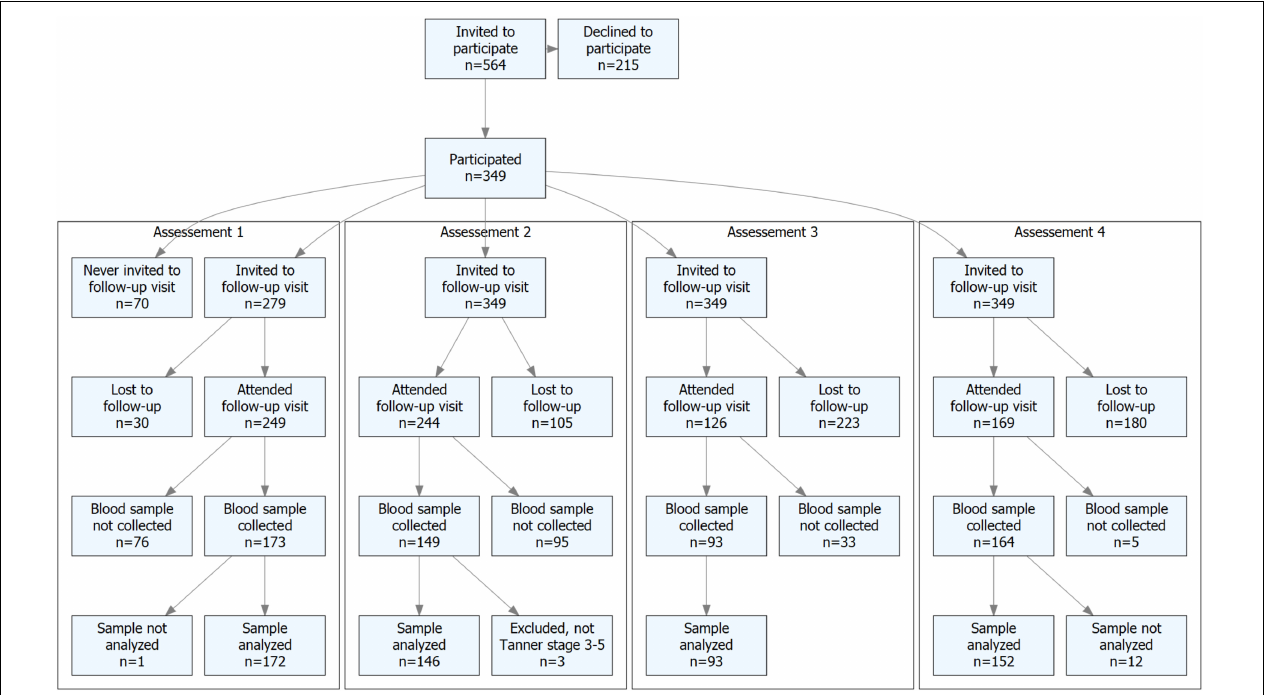
FIGURE 1 | Flowchart of study